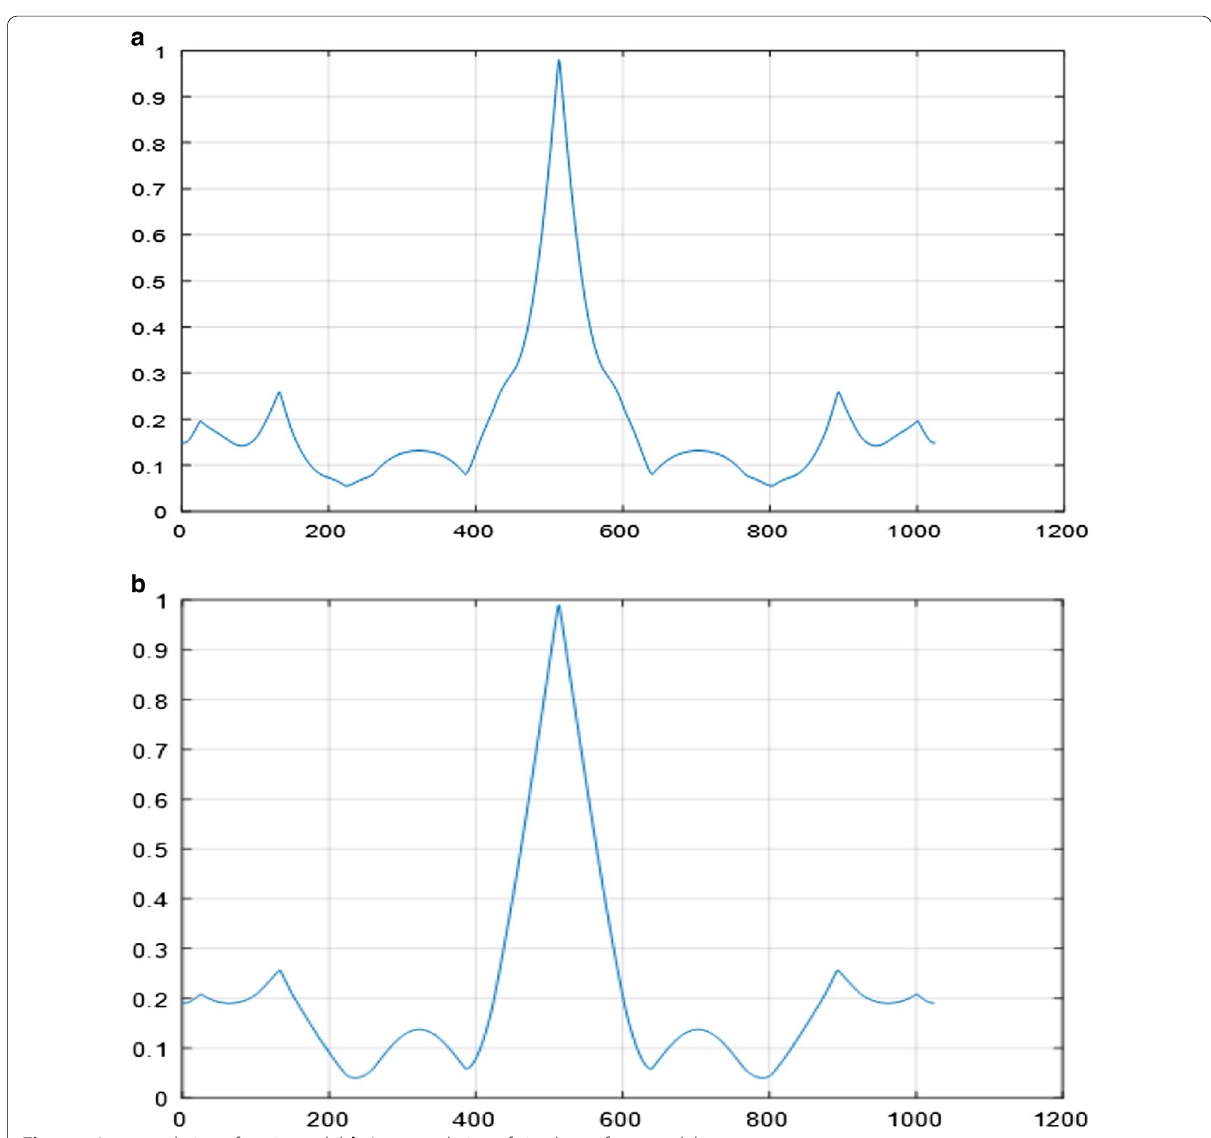
Fig. 7 a Autocorrelation of conic model. b Autocorrelation of circular uniform